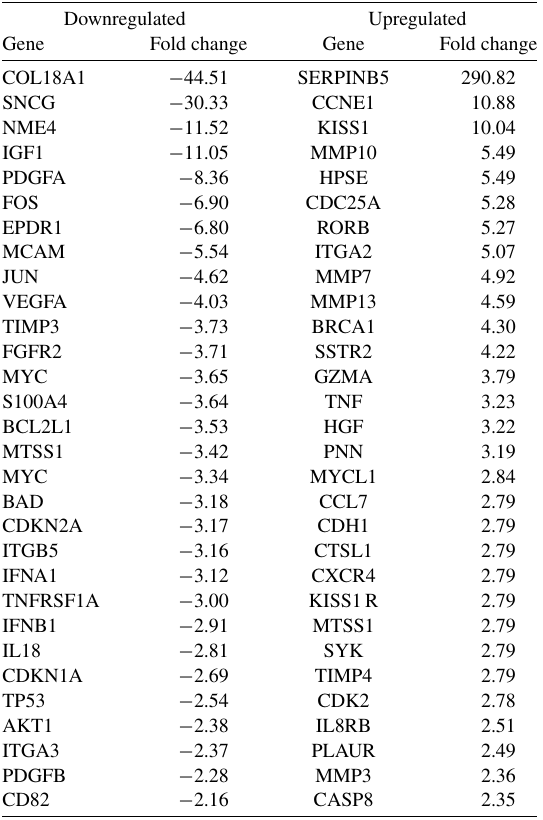
Changes in gene expression after treatment with Imatinib mesylate in an animal model of uveal melanoma Downregulated Upregulated Gene Fold change Gene Fold